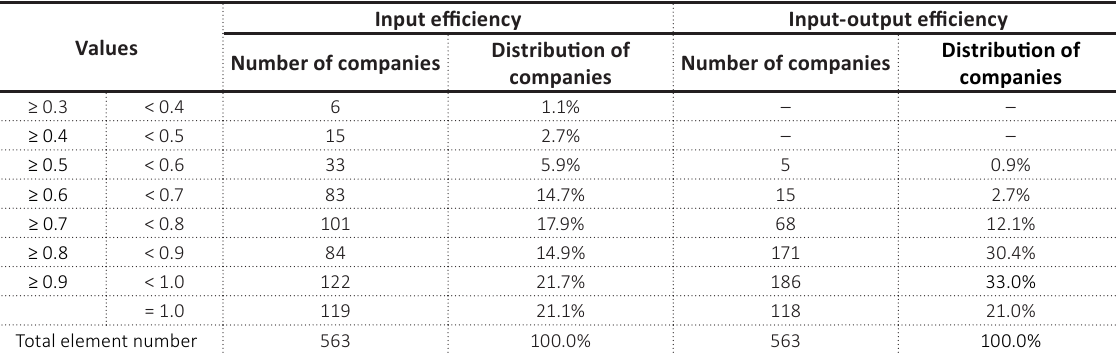
Table 3. Empirical distribution of input and input-output efficiency values based on the average of the